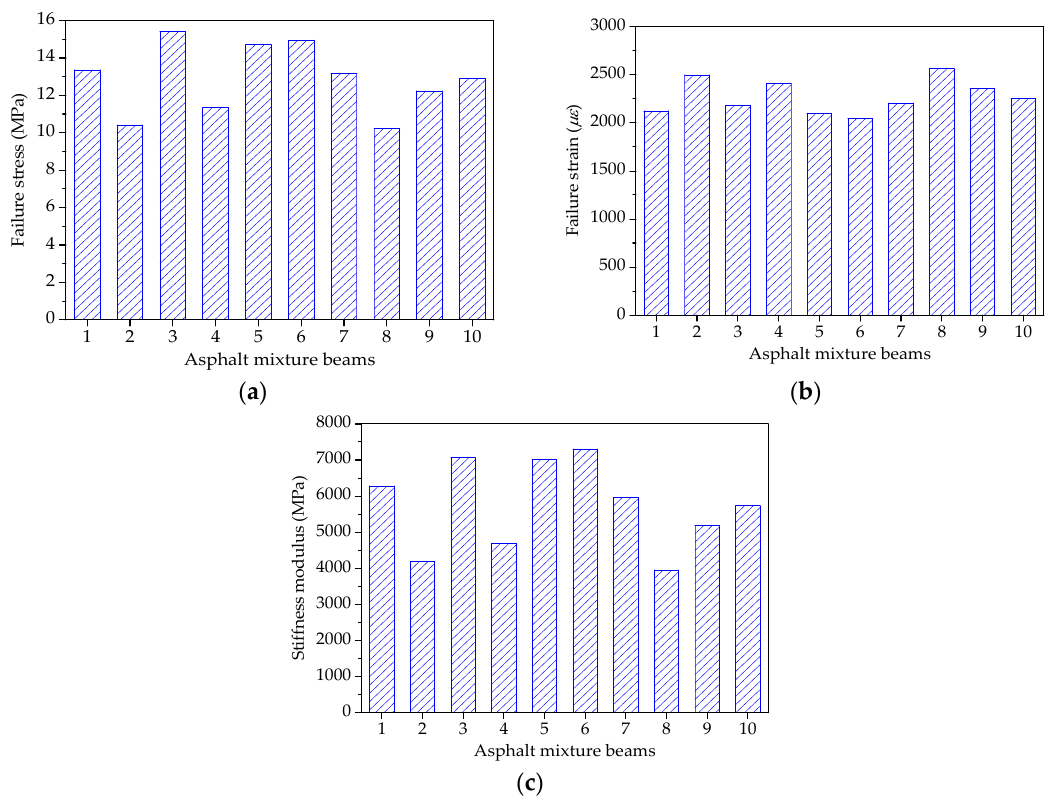
Figure 18. Failure results of asphalt mixture beams: ( a ) Failure stress; ( b ) Failure strain; and, ( c ) Stiffness modulus.